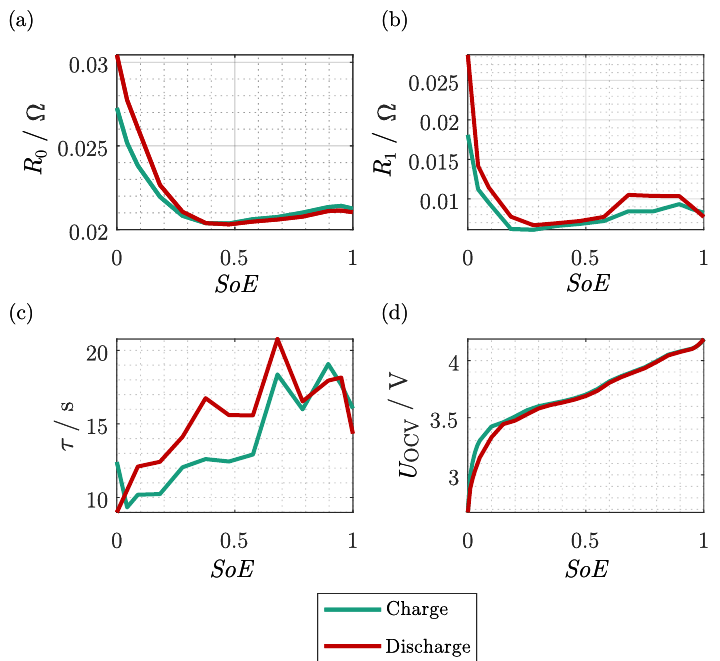
Figure A1. Chosen Parameters of the ECM for an NCA 18650 cell. Electrolyte and line resistance ( a ), charge transfer resistance ( b ), time constant of the charge transfer ( c ), and open circuit voltage ( d